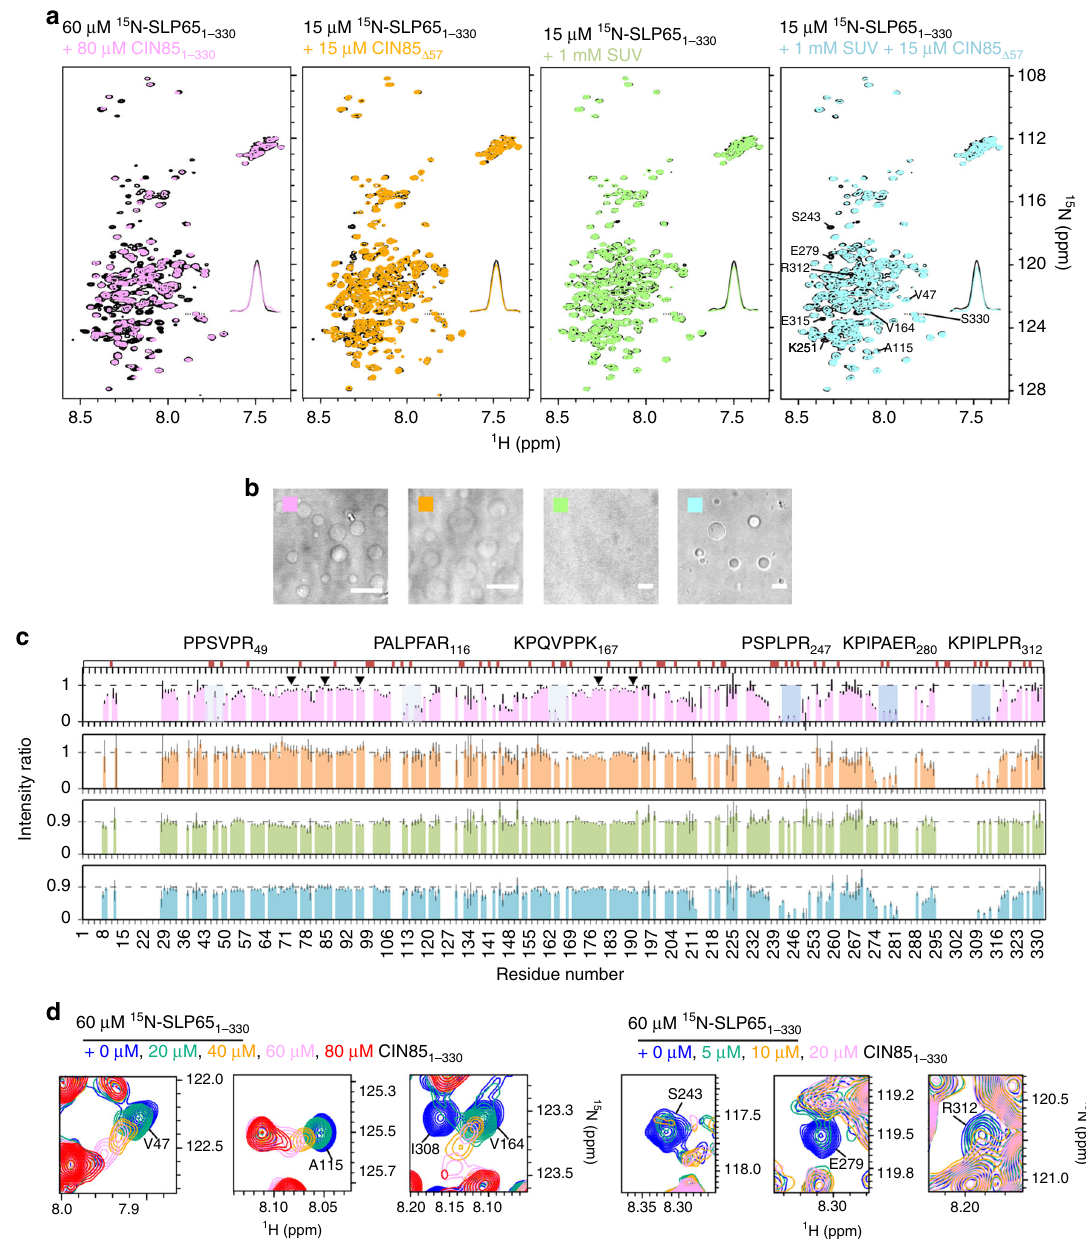
Fig. 4 Structural properties of phase-separated SLP65 and its interactions with CIN85. a 15 N-HSQC spectra of 60 µ M or 15 µ M of 15 N-labeled SLP65 only (black) were overlaid by the spectra of SLP65 after addition of unlabeled CIN85 1-333 (pink), CIN85 Δ 57 (orange), SUVs (green), or SUVs and CIN85 Δ 57 (cyan) at the indicated concentrations. b Bright fi eld images of the respective NMR samples denoted by colored boxes. (Scale bar = 10 µ m) c Residue- speci fi c peak intensity ratio of the 15 N-HSQC spectra shown in a of SLP65 with CIN85 1-333 (pink), CIN85 Δ 57 (orange), SUVs (green), or SUVs and CIN85 Δ 57 (cyan) over SLP65 only at the corresponding concentrations. Error bar indicates uncertainty propagated from the peak ’ s signal-to-noise. Proline residues were marked in red on top of the chart, while PRMs that interact with CIN85 were highlighted with their sequences written. The fi ve tyrosine residues that are phosphorylated by Syk (Y72, Y84, Y96, Y178, and Y189) were pointed out by inverted triangle. Source data are provided as a Source Data fi le. d Zoomed-in regions of 15 N-HSQC spectra of 60 µ M SLP65 titrated with increasing amounts of CIN85 1-333 were overlaid to show either shifting or disappearance of the respective peaks associated with different